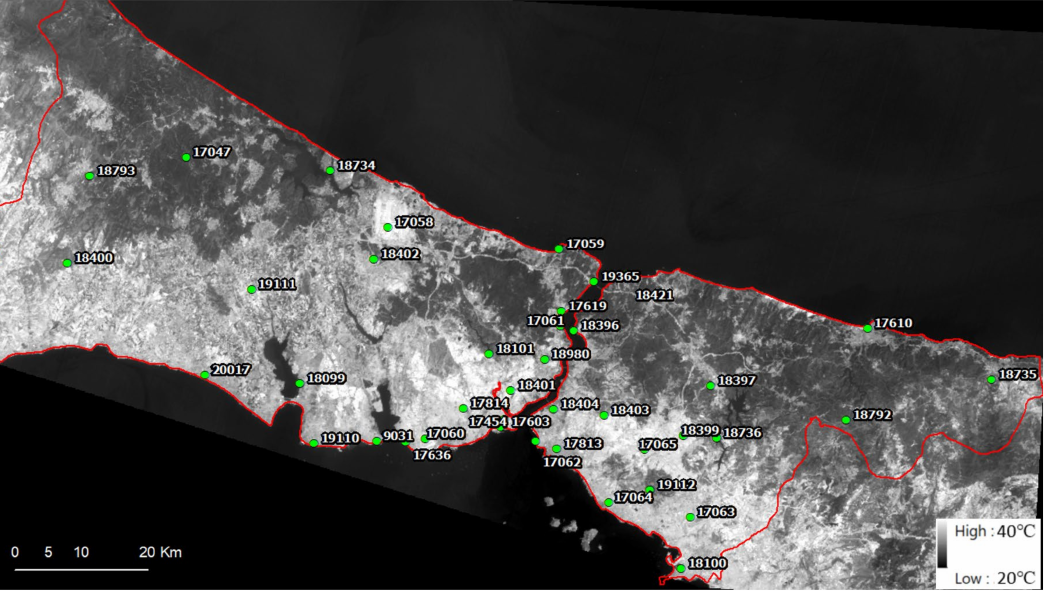
Figure 2. Meteorological stations with “International Meteorological Station Numbers” on 23 July 2022 Landsat LST image of